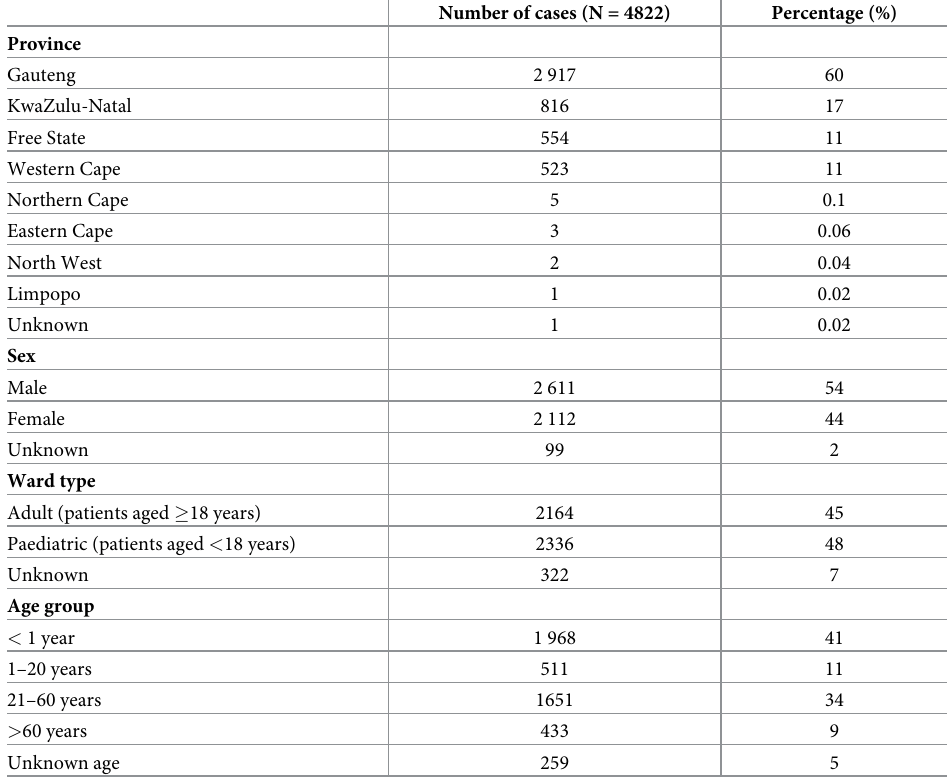
Table 1. Characteristics of Acinetobacter baumannii complex (ABC) cases in South Africa from 1 April 2017 to 30 September